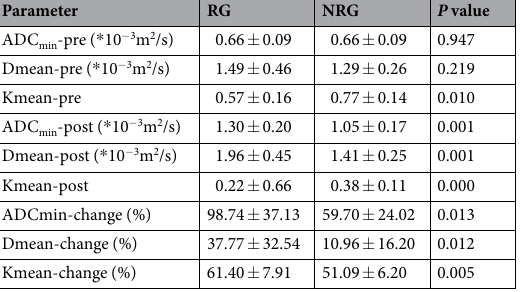
curve (AUC): 0.924; 95% confidence intervals (CI), 0.83–1.00) (Fig. 3).